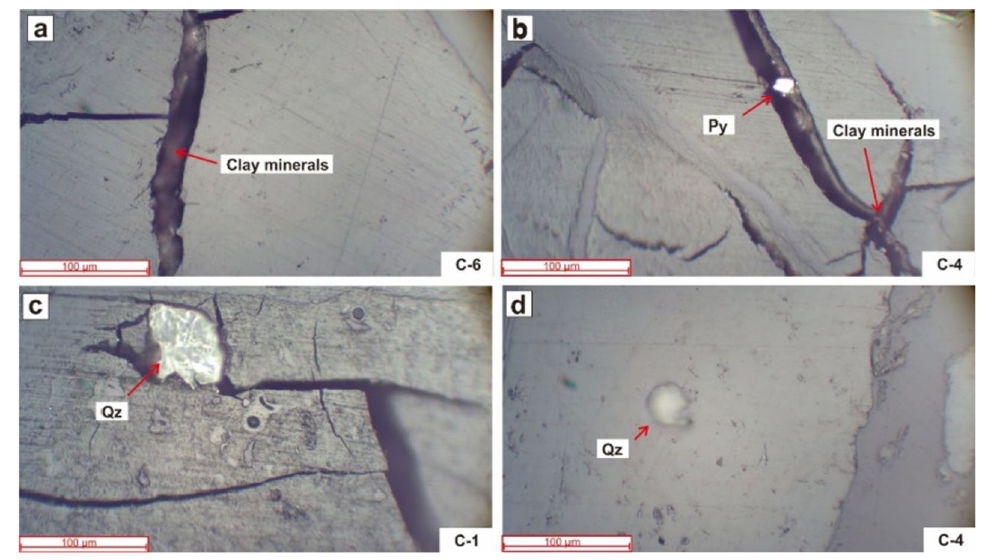
Fig. 4 Mineral matter in coal samples. (Clay minerals, pyrite (Py), and quartz (Qz); All photomicrographs are taken under white light)